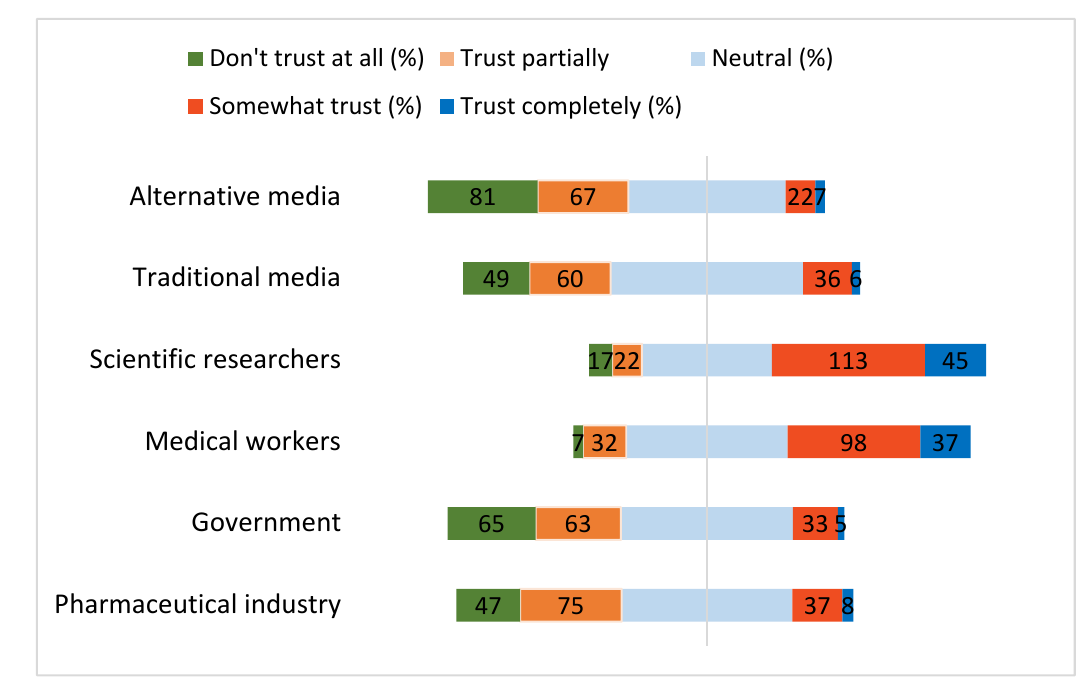
Figure 2. Respondents’ trust to information providers.